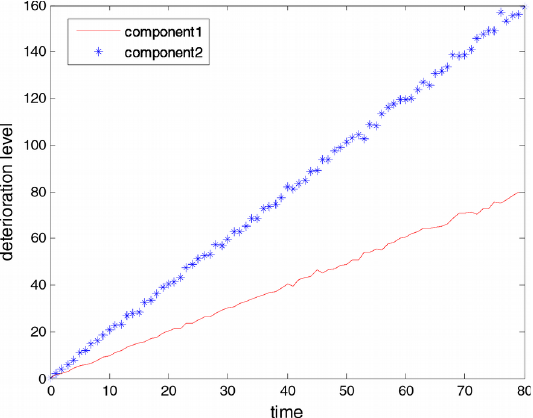
Figure 1. Degradation process of two components